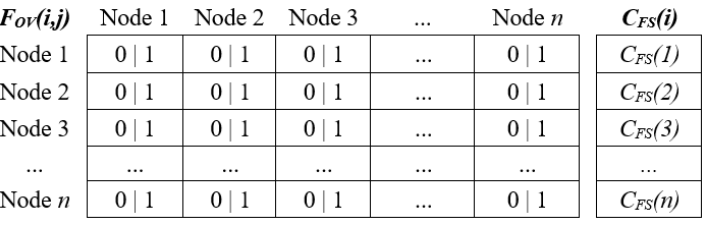
Figure 7. Table of flashover F OV ( i , j ) for calculating C FS ( i )